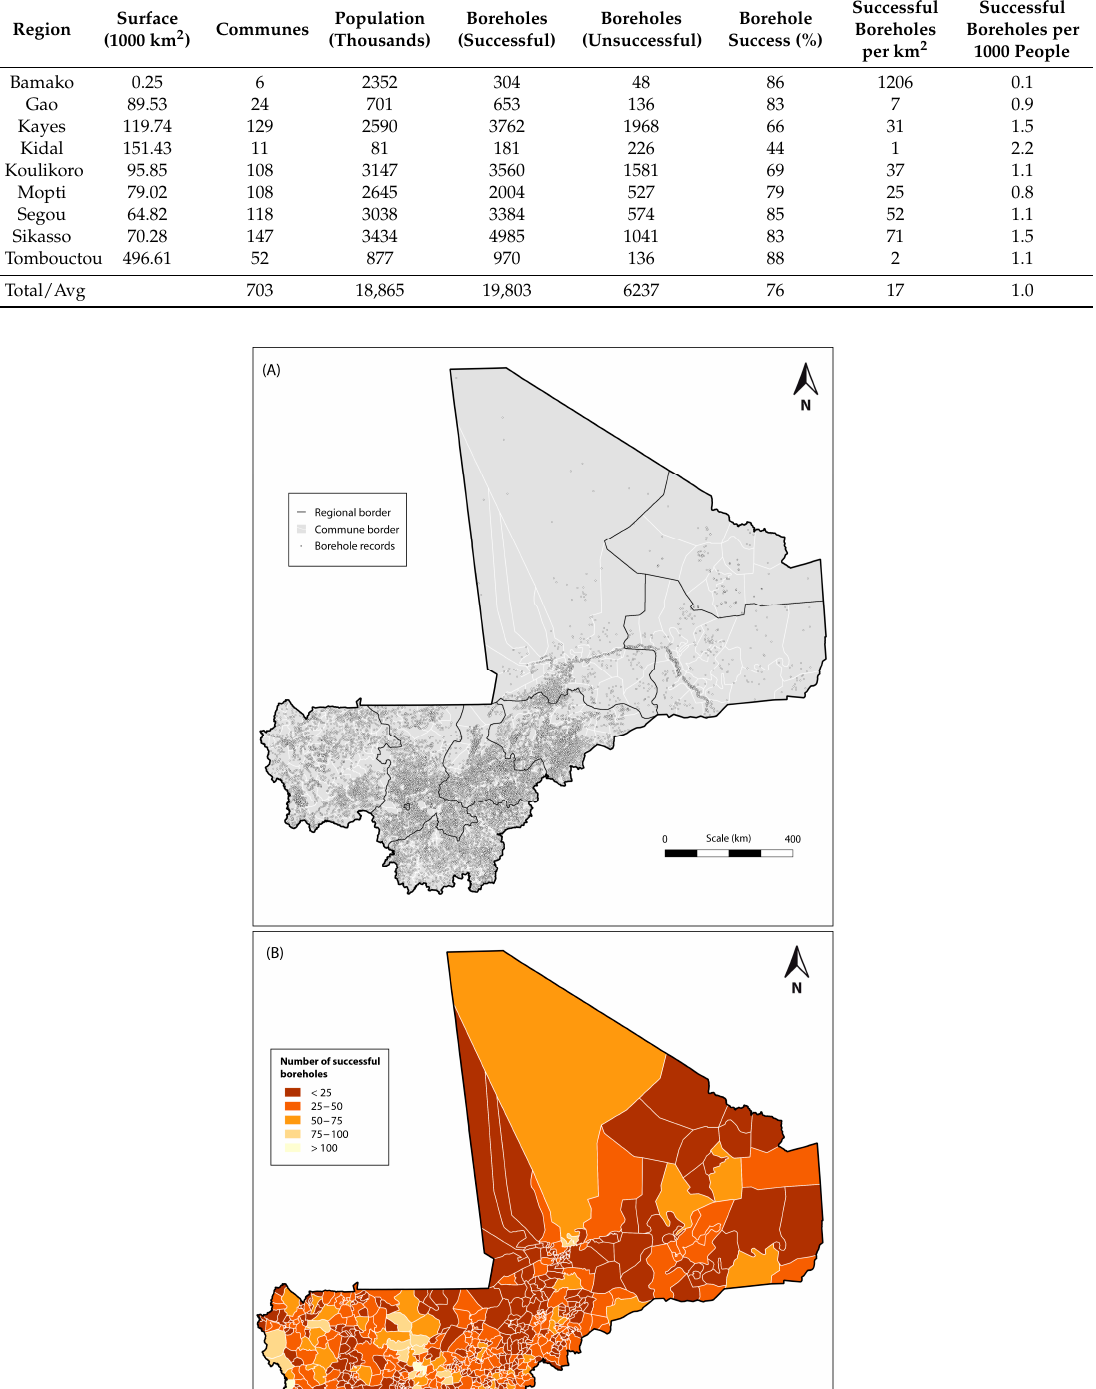
Table 2. Communes, surface area, population and basic borehole data in Mali, by region [3]. Surface Population Region Communes (1000 km 2 ) (Thousands) Bamako